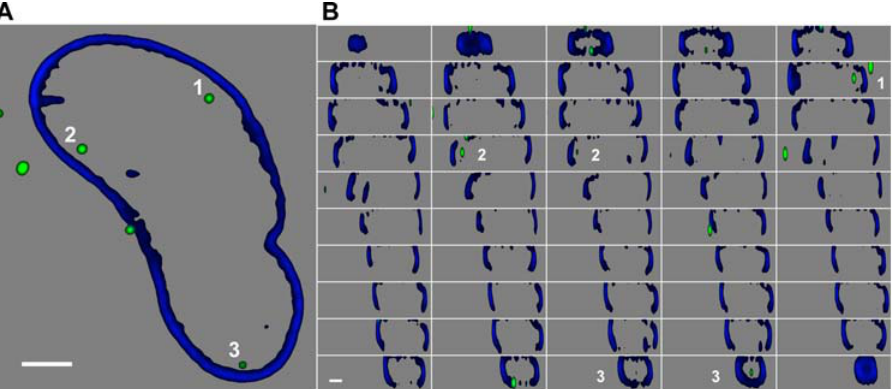
Figure 5. Nuclear visualization of the HIV-IN-ECFP virus. Nucleus of a HeLa cell infected with the HIV-IN-ECFP virus (green) and immunostained with lamin A/C (blue). Acquisition of confocal images was performed as z stack with a z step size of 0.3 m m and was followed by deconvolution based on experimentally determined PSF (see Experimental Procedure). (A) x-y section taken approximately at half high of the analyzed nucleus. (B) Adjacent vertical projections taken every 0.301 m m from upper (top-left panel) to lower side (bottom-right panel) of the nucleus in (A). Bars, 5 m m.